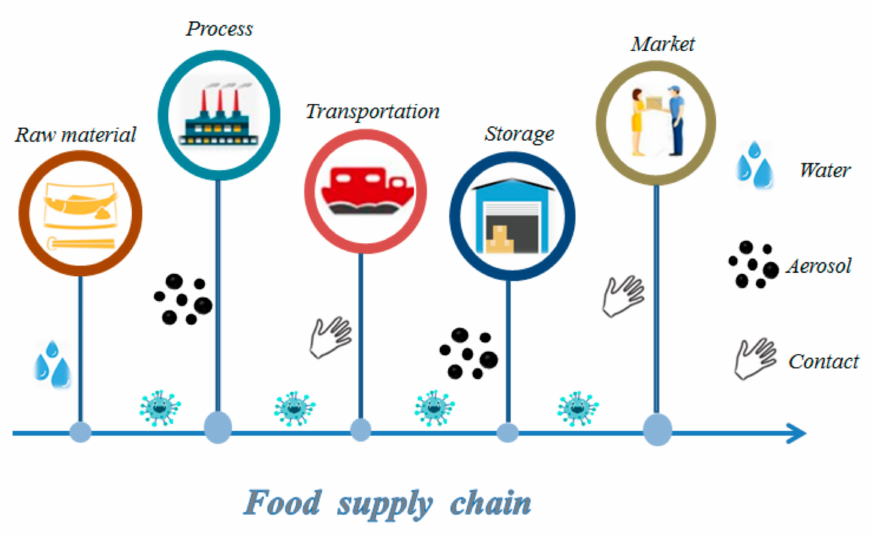
Figure 2. The possible transmission of SARS-CoV-2 in a food supply chain via three main means: water, aerosol, and